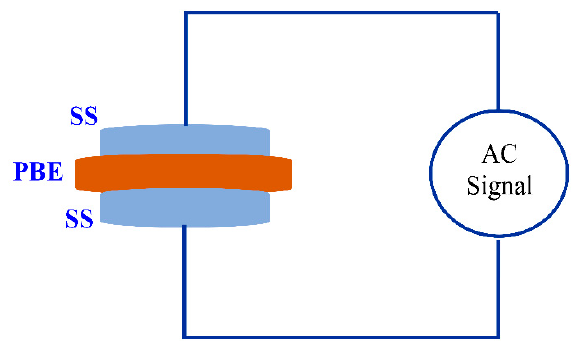
Figure 3. Schematic diagram of impedance measurement which consists of two identical stainless steel (SS) electrodes. The inserted sample is a polymer blend electrolyte (PBE). Table 1. Calculated DC conductivity for neat CS:PEO and blend electrolyte films at room temperature.